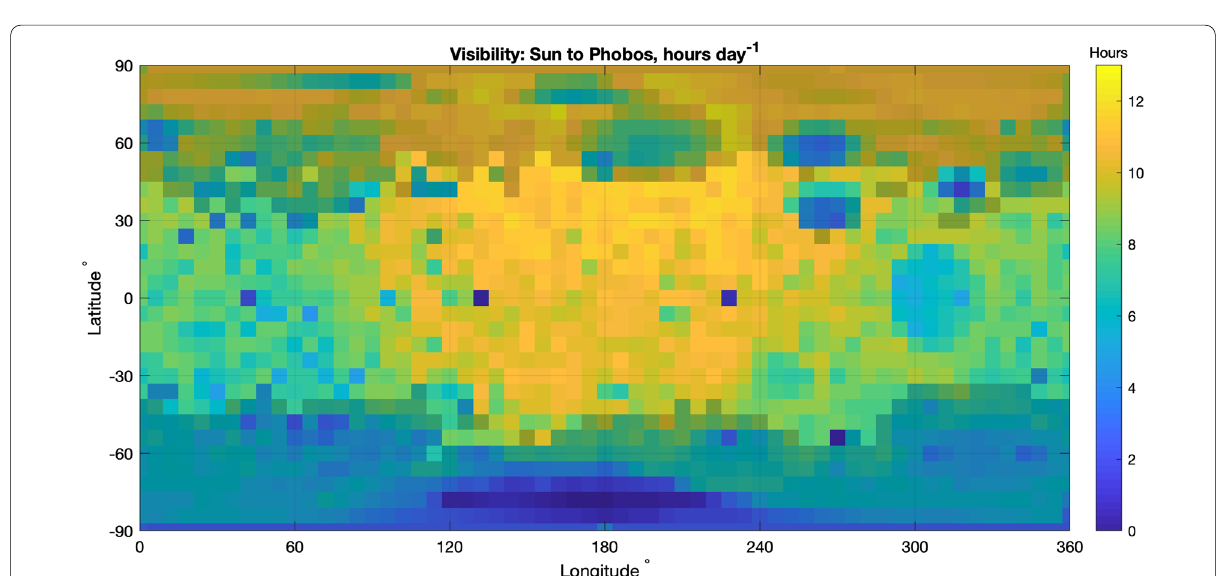
Fig. 7 Map of Phobos. Mean Sun to Phobos visibility hours per day averaged over the period (1 Jan 2030 – 18 Nov 2031). The shaded area represents locations where any single day in that period contains less than 4.5 hours visibility between the Sun and